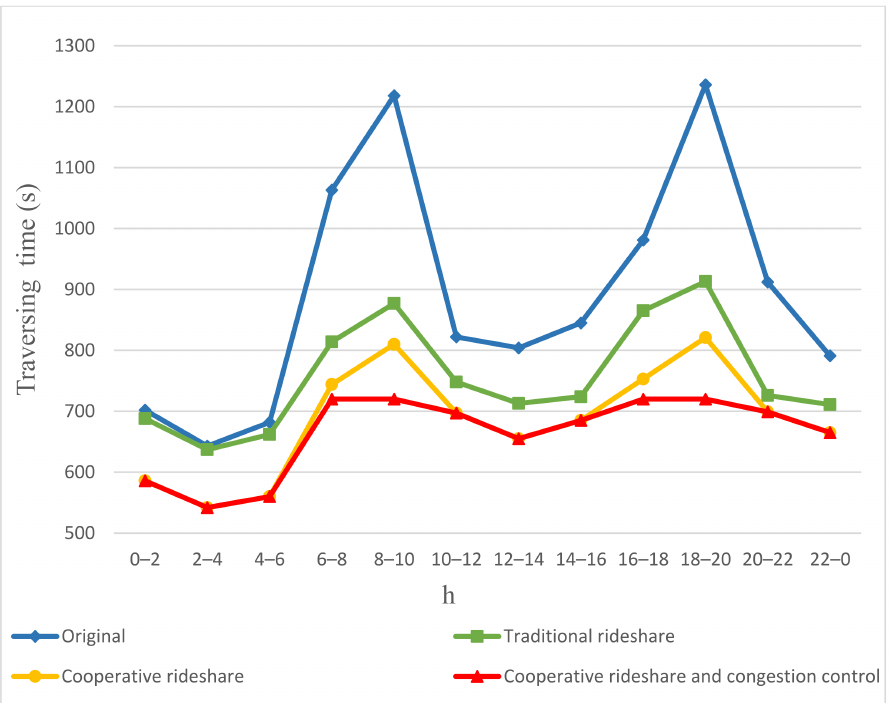
Figure 16. Traversing times of PEV/SAEV passengers on the major arterial